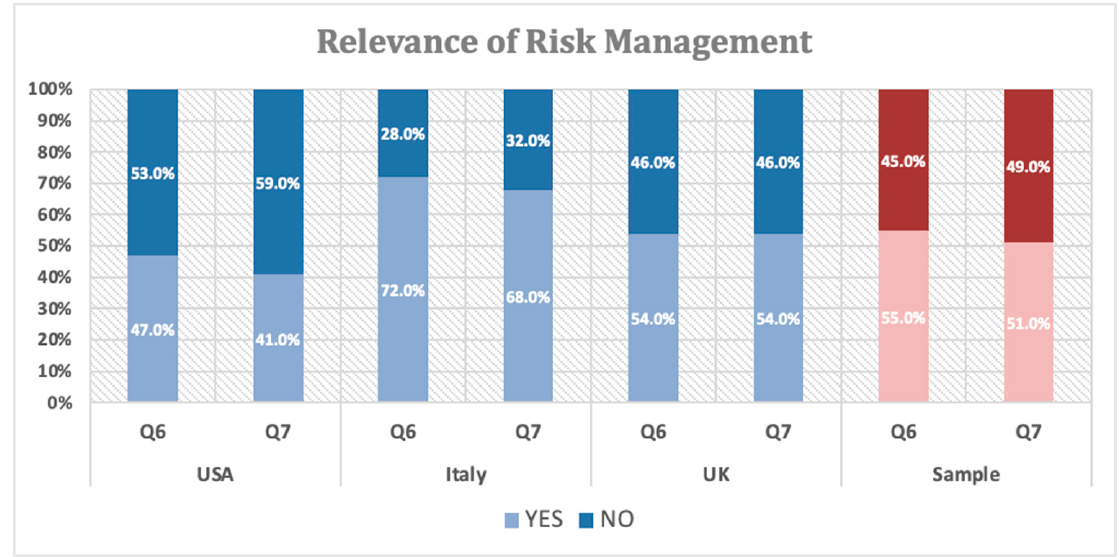
Figure 4. Answers to questions about the relevance of risk management (6 and 7) by country of respondents.